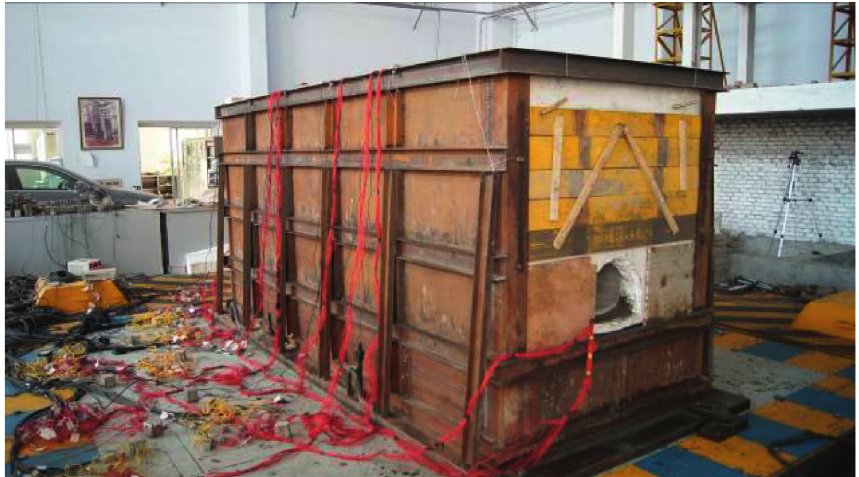
Figure 5: Photograph of the shaking table